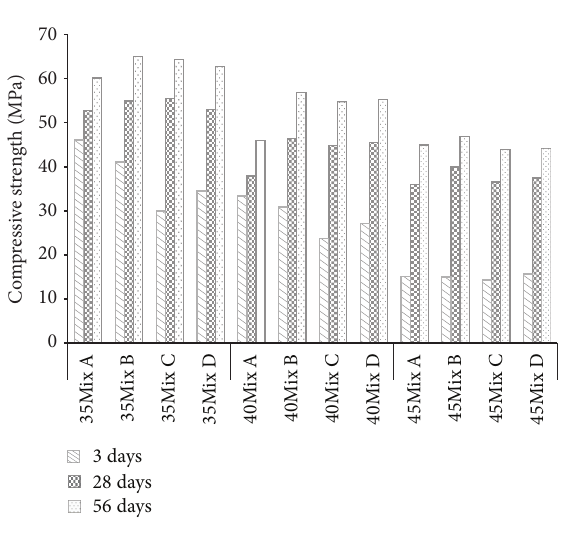
Figure 8: Compressive